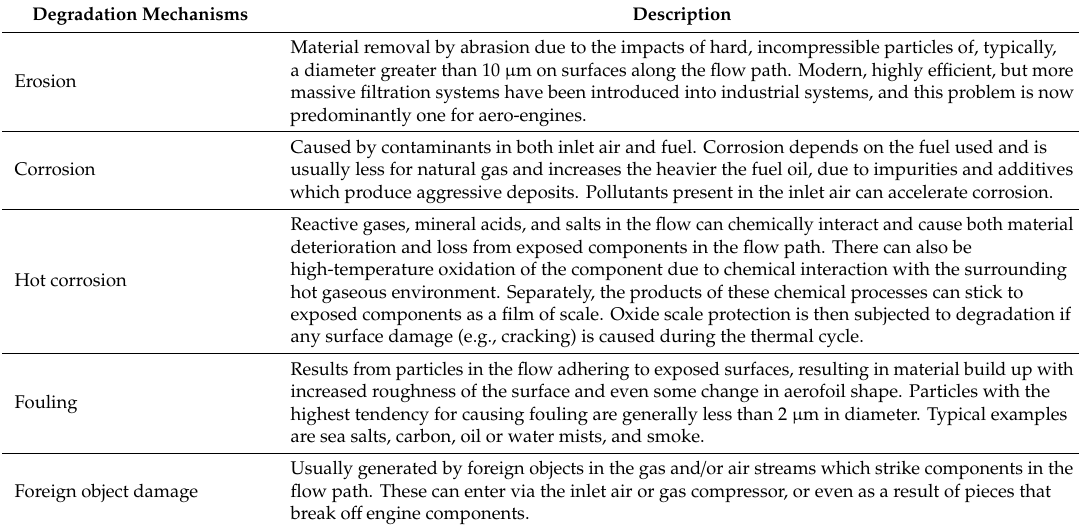
Table 2. Components degradation mechanisms